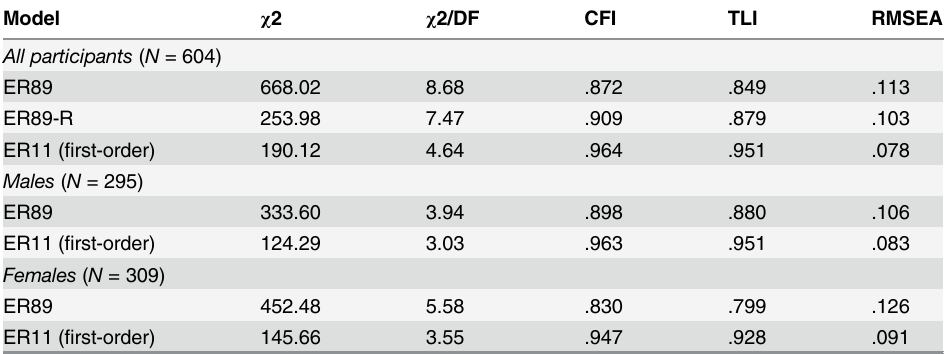
Table 9. Structural validity of the ER11 on the representative sample and separately for male and fe- male respondents. Model χ 2 χ 2/DF CFI TLI RMSEA All participants ( N = 604) ER89 668.02 8.68 .872 .849 .113 ER89-R 253.98 7.47 .909 .879 .103 ER11 ( fi rst-order) 190.12 4.64 .964 .951 .078 Males ( N = 295) ER89 333.60 3.94 .898 .880 .106 ER11 ( fi rst-order) 124.29 3.03 .963 .951 .083 Females ( N = 309) ER89 452.48 5.58 .830 .799 .126 ER11 ( fi rst-order) 145.66 3.55 .947 .928 .091